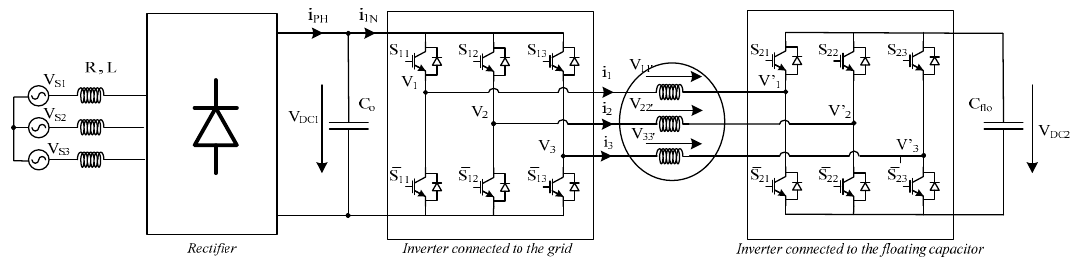
Figure 2. VSD with a multilevel inverter-based on dual 3-phase VSIs.